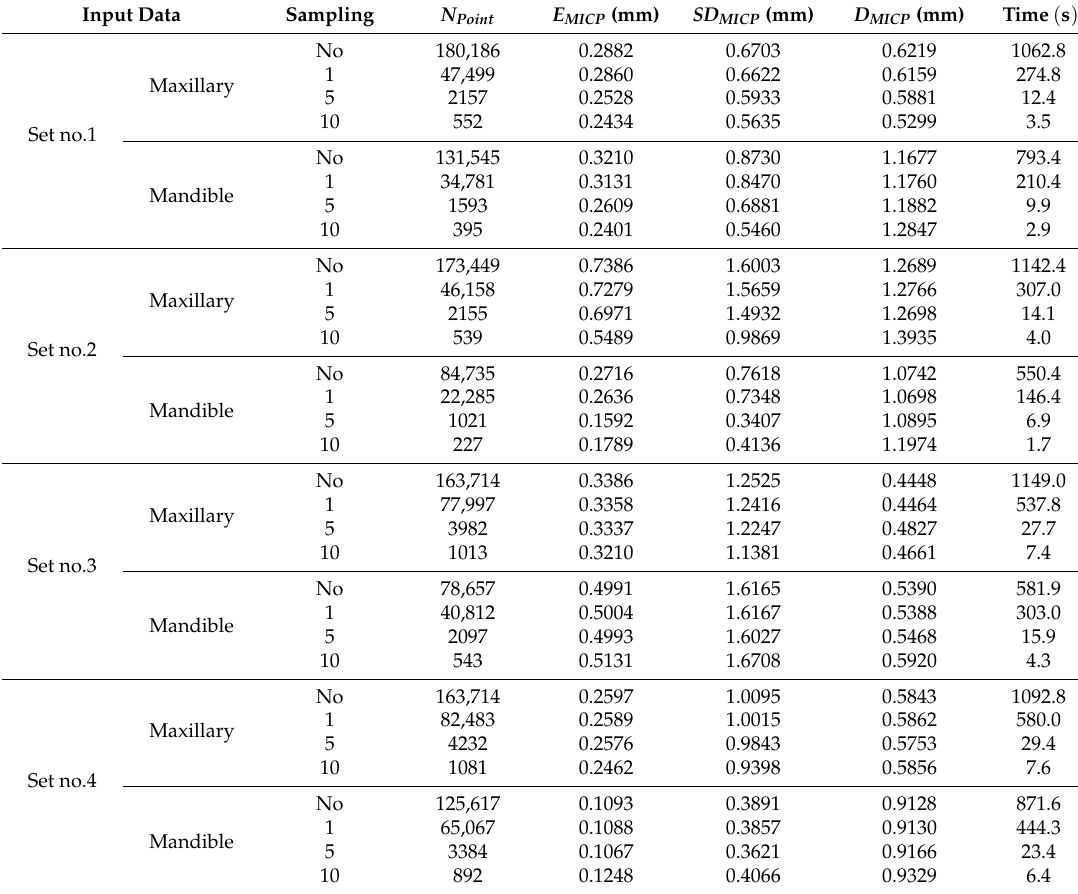
Table 4. MICP registration results using uniform down sampled data.